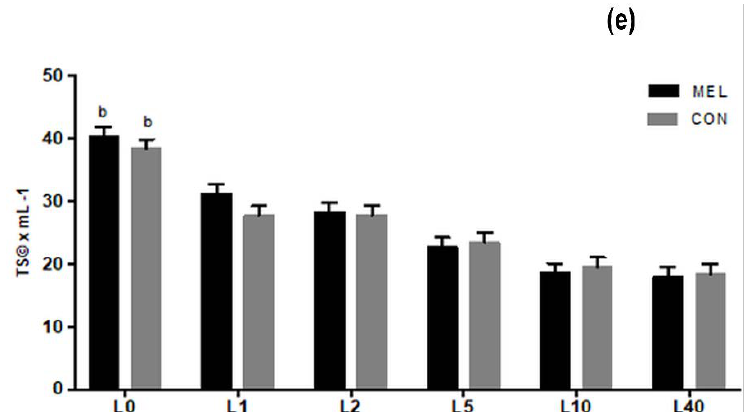
Figure 6. Least squares means ± SEM of chemical analysis in terms of proteins ( a ), fat B ( b ), lactose ( c ), SNF ( d ) and TS© ( e ) content in colostrum/milk, in control group (CON) and in melatonin group (MEL), at lambing (L0) and on days 1 (L1), 2 (L2), 5 (L5), 10 (L10) and 40 (L40), p < 0.05, a: among the two groups, b: within time.